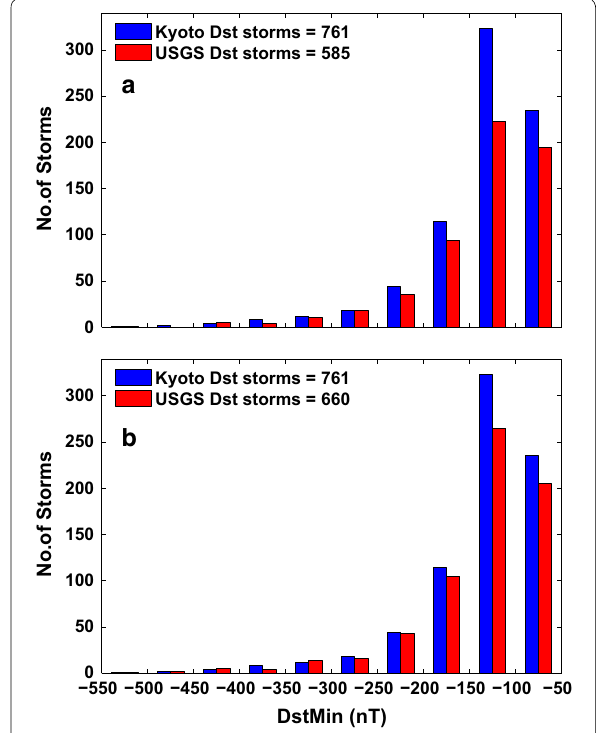
Fig. 3 Distributions of DstMin in Kyoto Dst and USGS Dst ( a ) and the same after shifting USGS Dst by